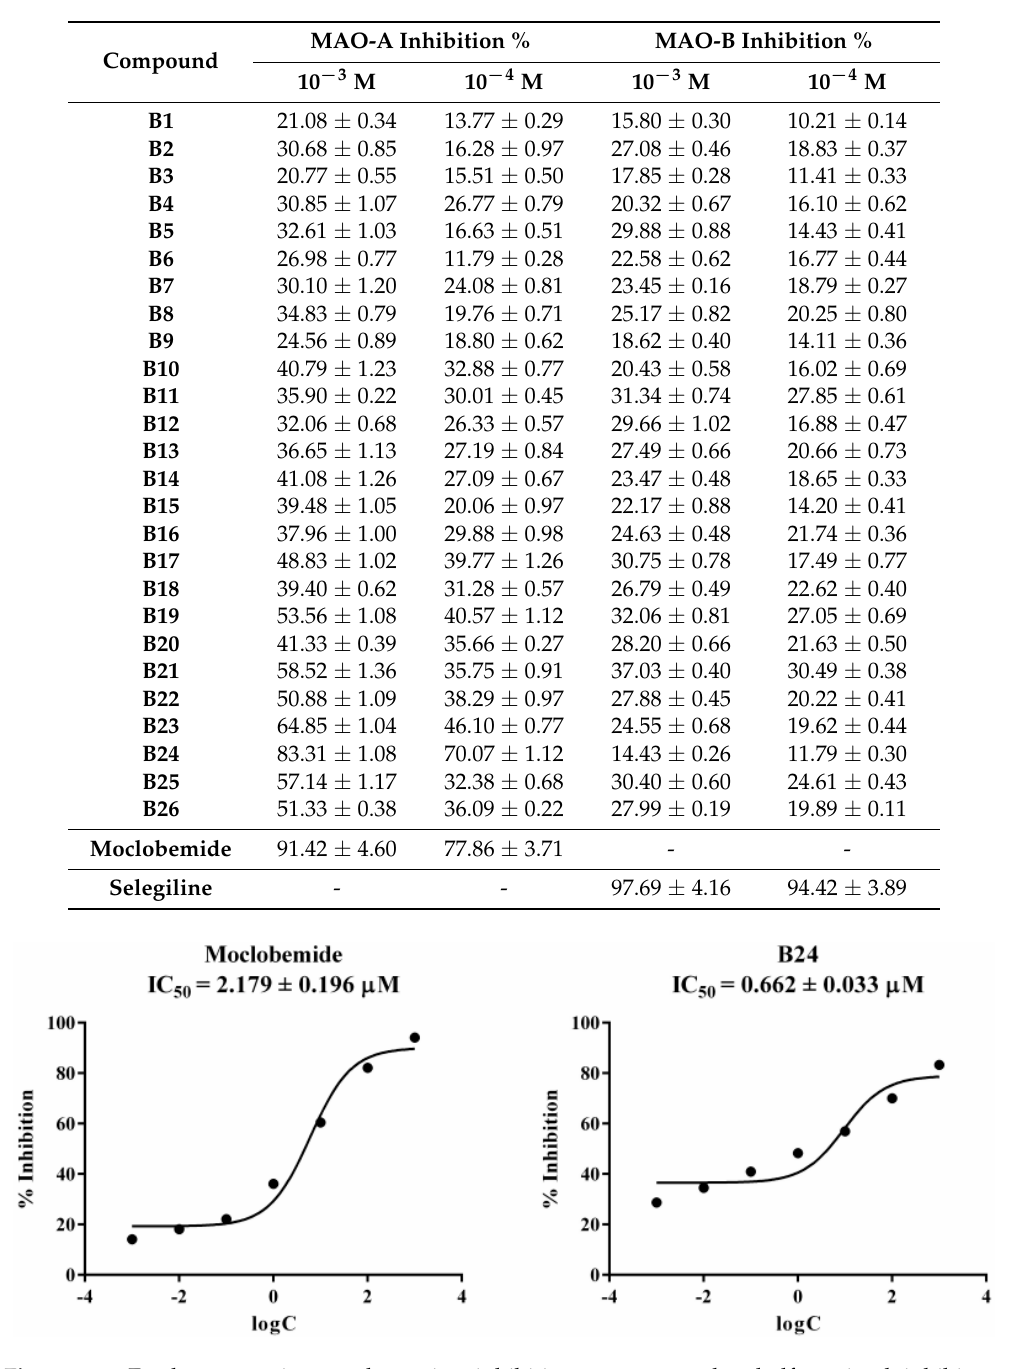
Figure 1. Further screening to determine inhibition potency and a half-maximal inhibitory concentration (IC 50 ) values of B24 and moclobemide against MAO-A.